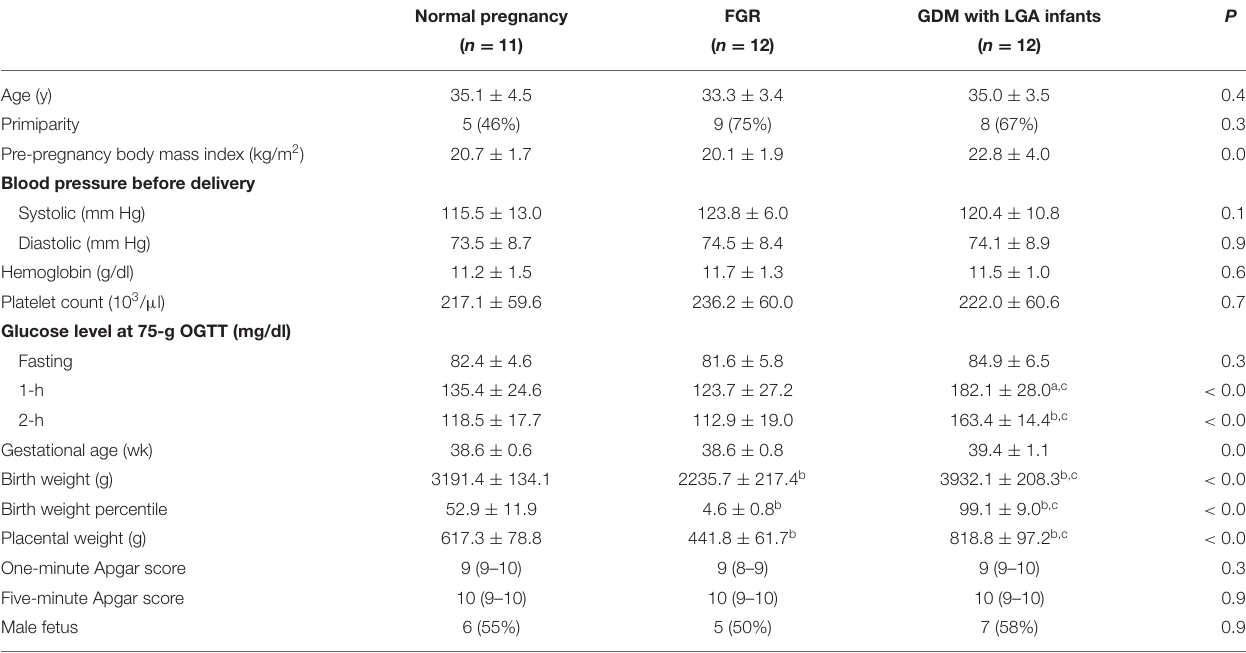
TABLE 2 | Characteristics of the study population. Normal pregnancy FGR GDM with LGA infants